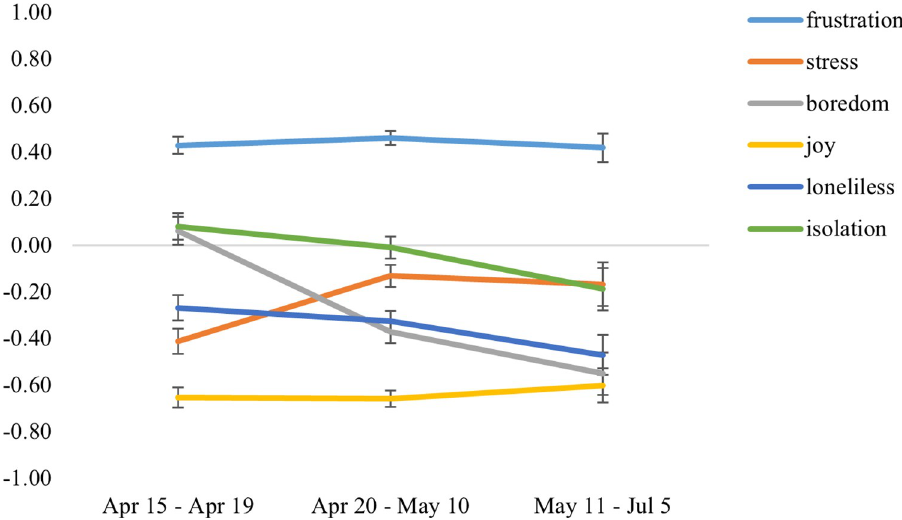
Fig 3. Reported changes in emotional states plotted against the timeline of